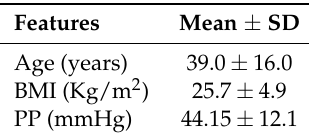
Table 2. Anthropometric feature mean ( ± Standard Deviation (SD)) of the PPG endothelial dysfunction dataset